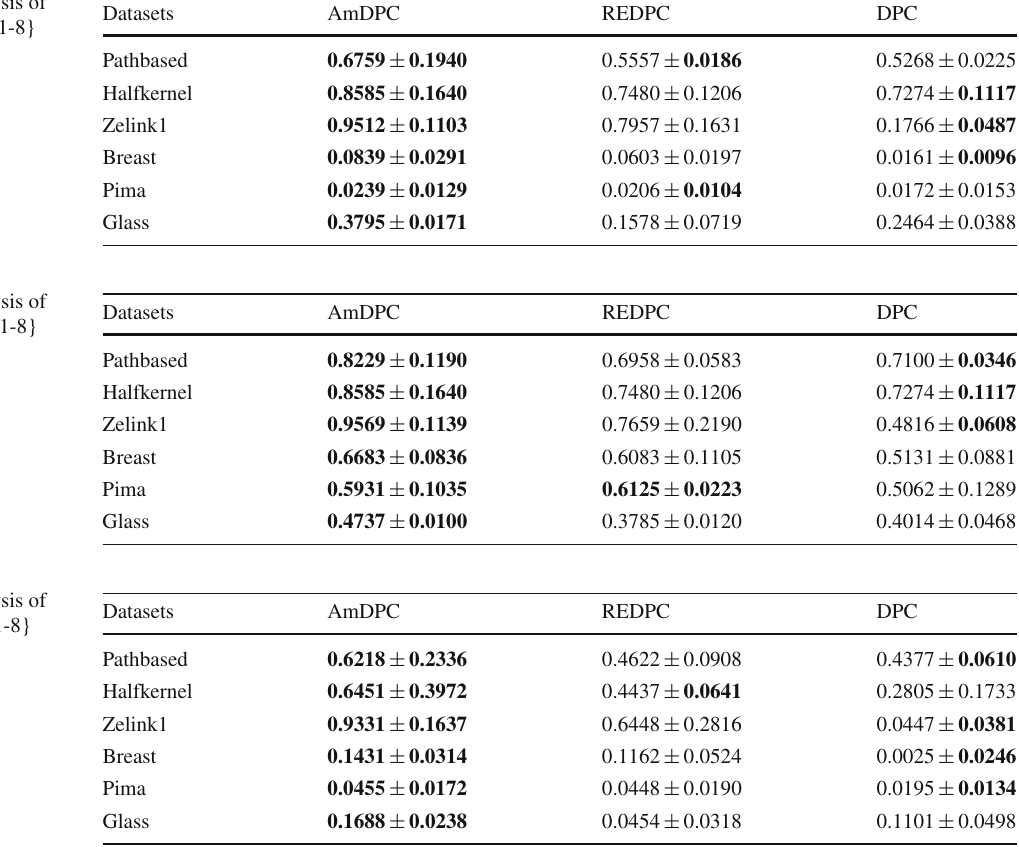
Table 7 Sensitivity analysis of NMI indicator when p ={1-8}